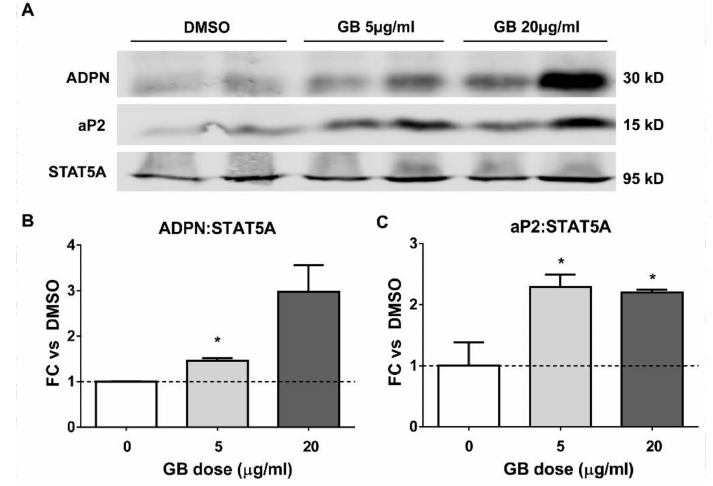
Figure 2. Groundsel bush promotes aP2 and adiponectin (ADPN) expression during the adipogenesis of 3T3-L1 cells. 3T3-L1 preadipocytes were induced to differentiate using standard induction cocktail containing either 5 or 20 µ g/mL of groundsel bush (GB). Five days after the induction of differentiation, whole-cell extracts were isolated for Western blot analysis, using 125 µ g total protein per lane ( A ); ( B , C ) Densitometric quantification of aP2 and ADPN band intensities shown in ( A ). n = 2 bands per treatment. * indicates p < 0.05 vs. DMSO control. Results shown are from duplicate cell culture wells; this experiment was conducted twice on independent batches of